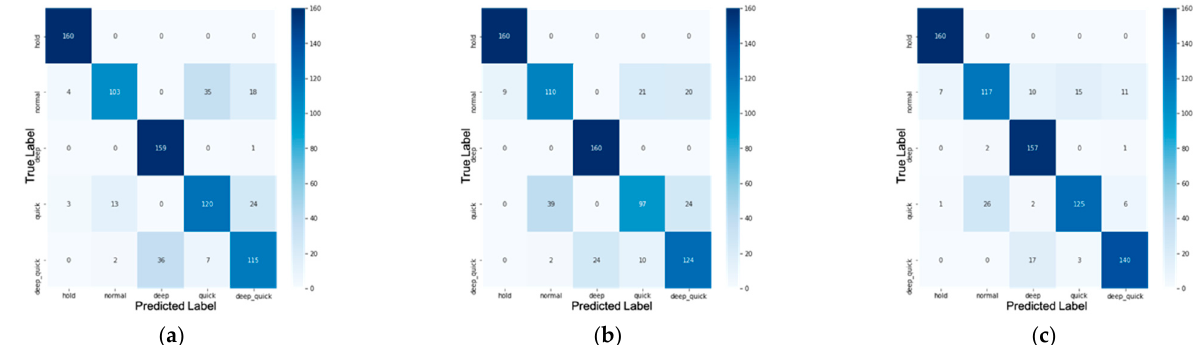
Figure 10. Confusion matrix for ( a ) raw data, ( b ) data with statistic feature extraction, and ( c ) data with MFCC feature extraction on training stage.